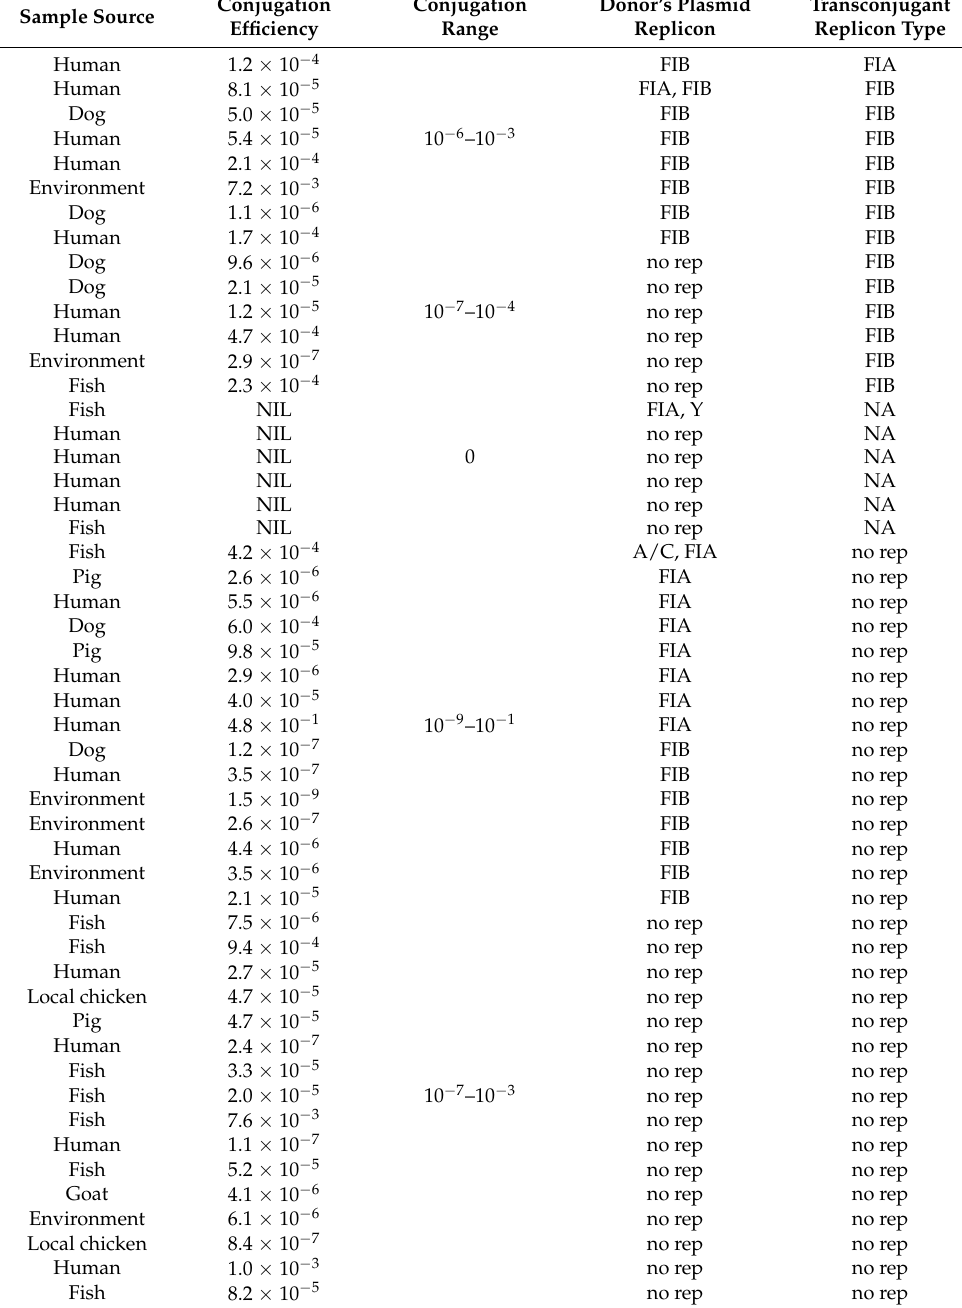
Table 4. Replicon types of plasmids carrying bla CTX-M-15 among donors and transconjugants. Sample